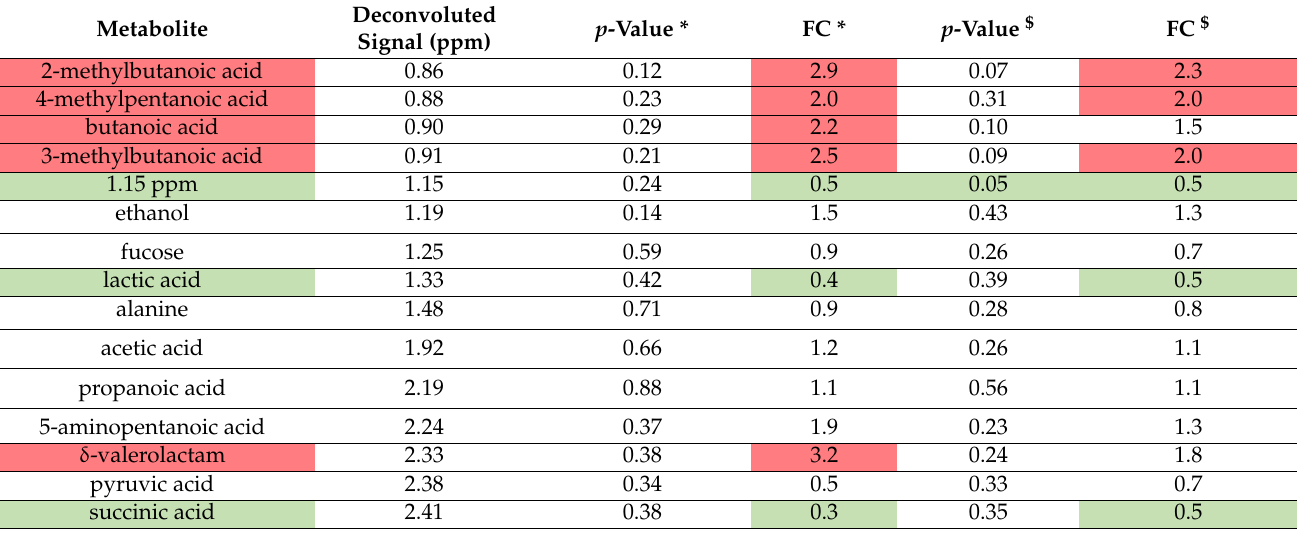
Table 3. Results of t-test ( p value) and fold-change (FC SS/HC) analyses of deconvoluted signals of SS and HC samples. Metabolites highlighted in red were higher in pSS, those in green were higher in